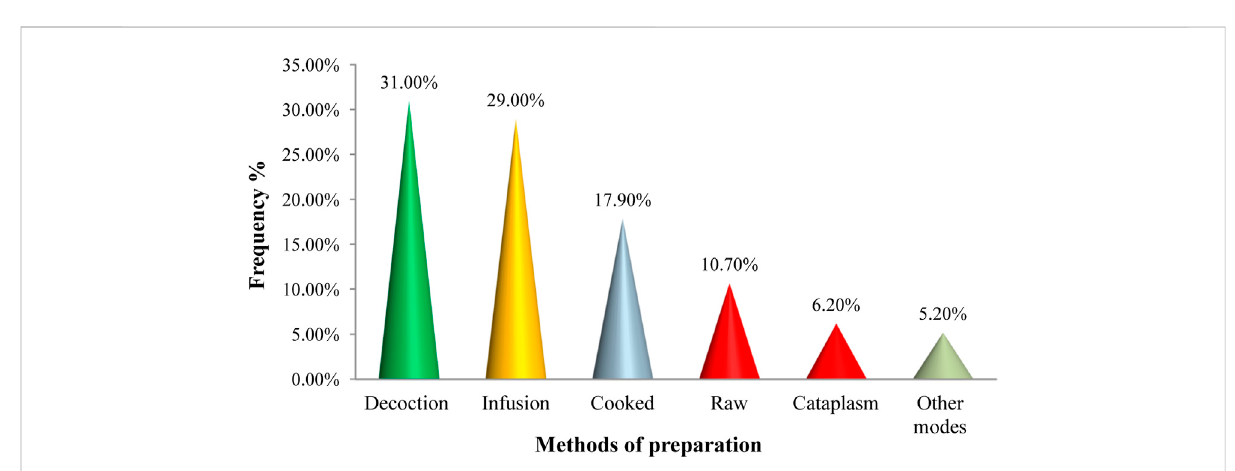
FIGURE 3 Parts of medicinal plants used in the study area.